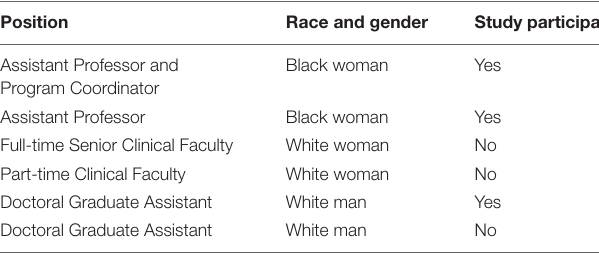
TABLE 2 | Program